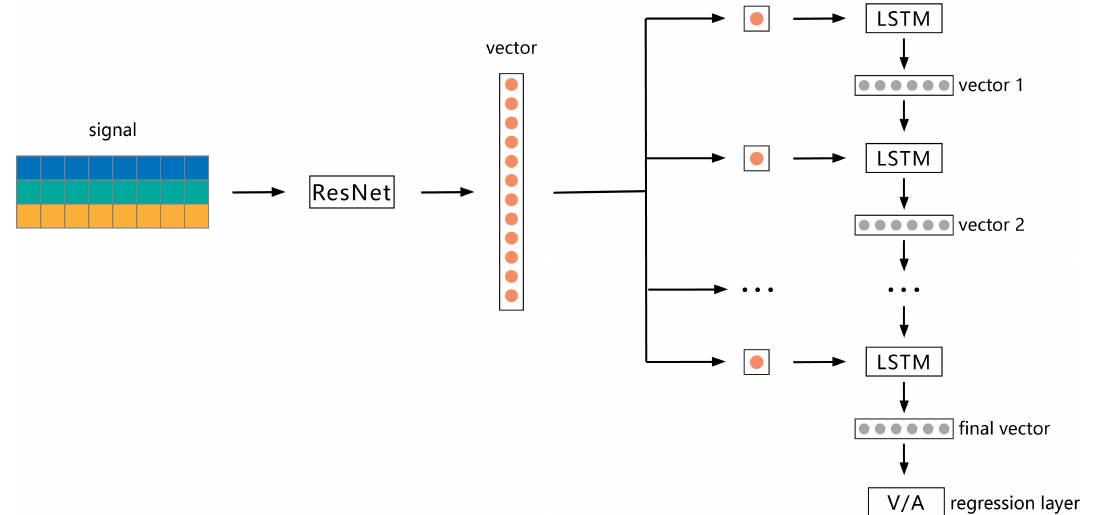
Figure 6. ResNet-LSTM model. The signal is first fed into ResNet as a three-channel input (phasic, tonic, and